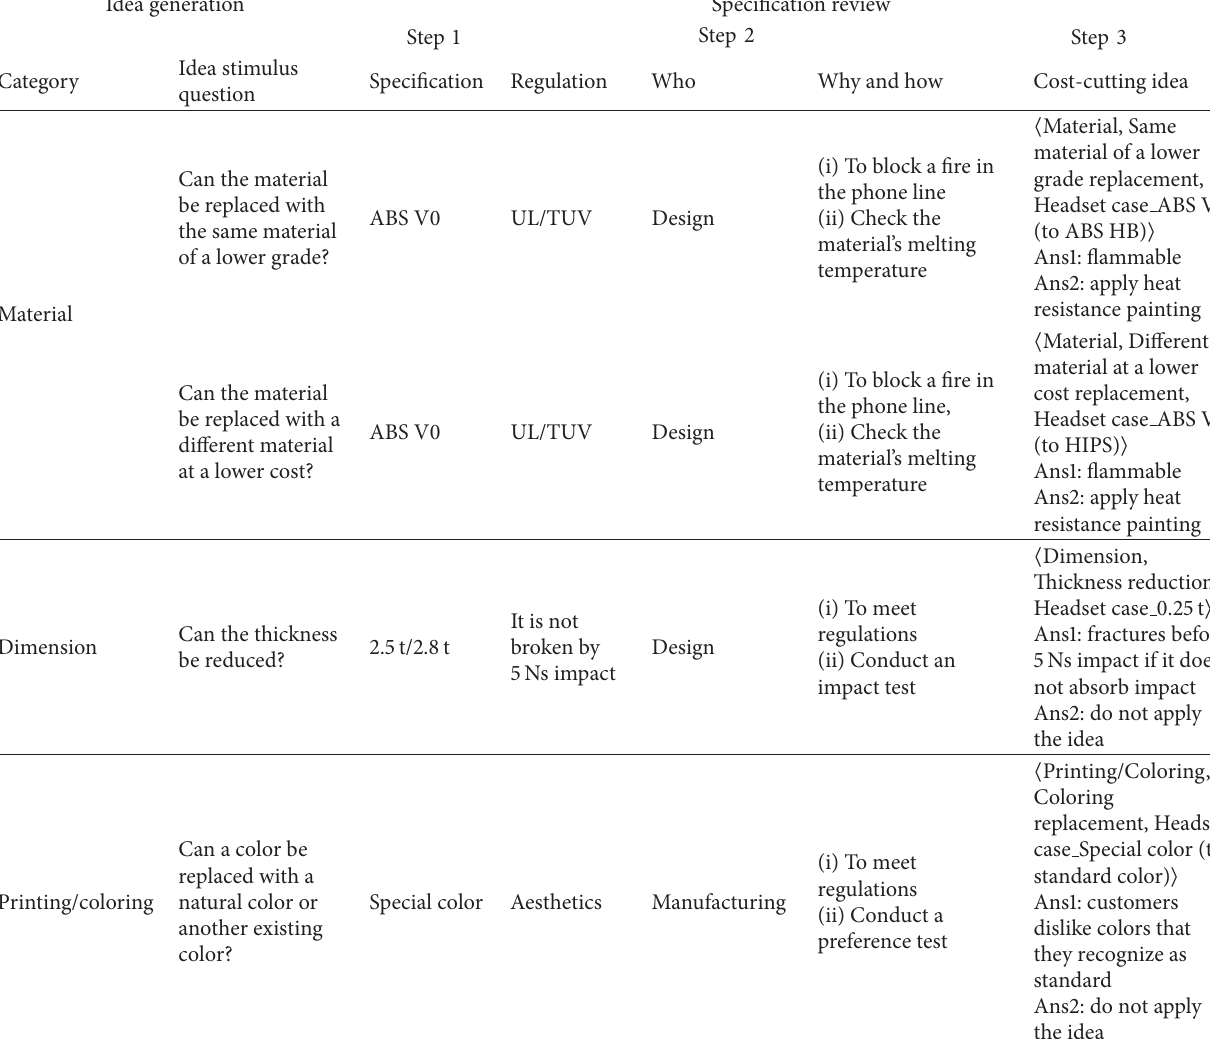
Table 12: Specification review process for handset